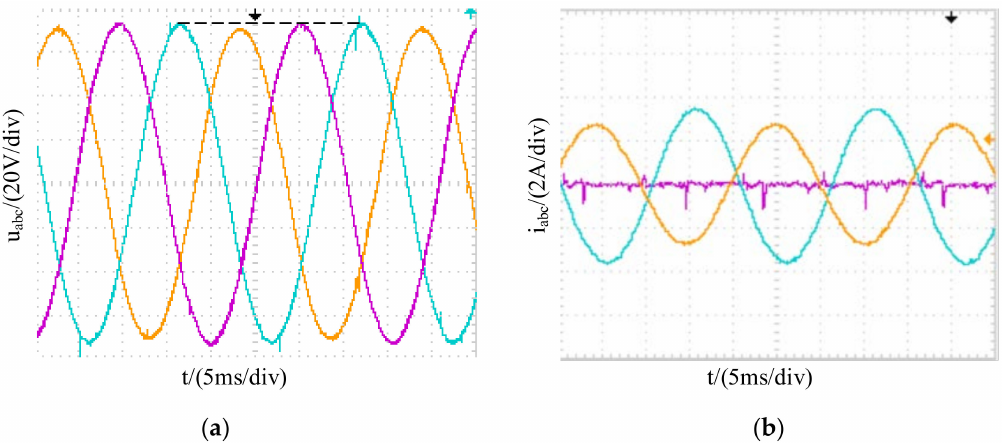
Figure 15. Three-phase output voltages and currents only with the improved droop control in the case of an unbalanced load. ( a ) Voltage waveforms; ( b ) Current waveforms.